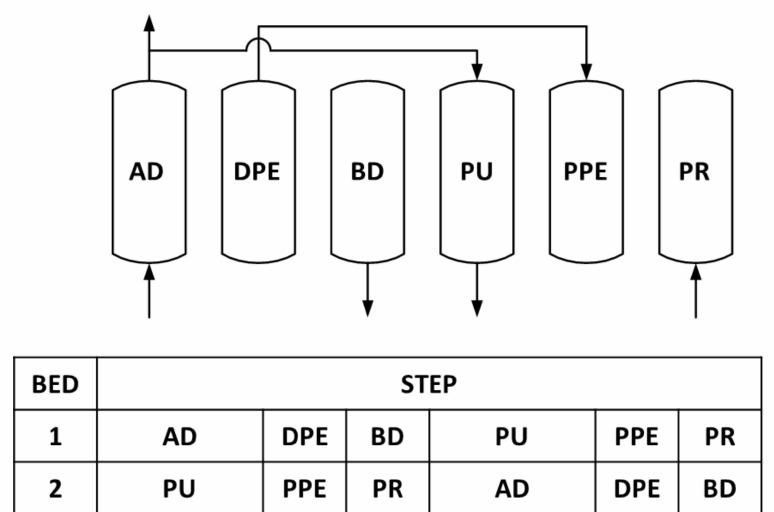
Figure 3. Configuration of the 2-bed, 6-step modified Skarstrom cycle with pressure equaliza- tion (AD: Adsorption, DPE: Depressurizing pressure equalization, BD: Blowdown, PU: Purge, PPE: Pressurizing pressure equalization, PR: Feed pressurization; t AD = t PU = 250 s, t BD = t PR = 50 s, t DPE = t PPE = 25